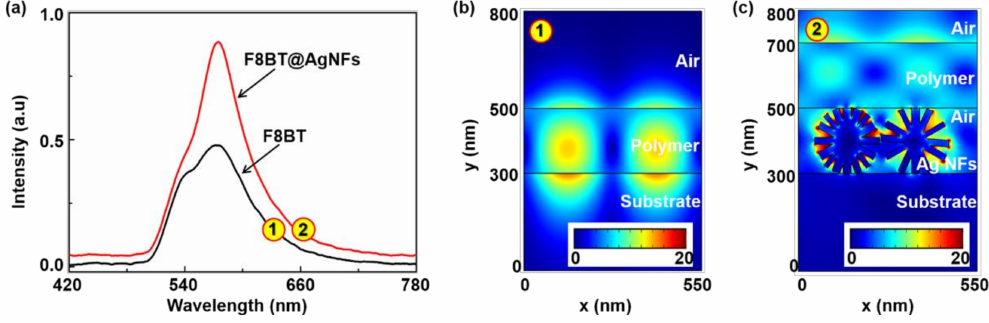
Figure 3. ( a ) Normalized photoluminescence spectra of F8BT membrane (black curve) and F8BT / Ag NFs film (red curve). Electric field distributions of ( b ) the polymer waveguide and ( c ) the F8BT / Ag NFs structure at 566.7